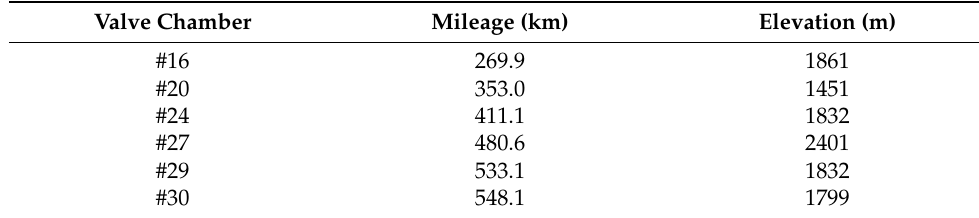
Table 4. The positions of some of the valve